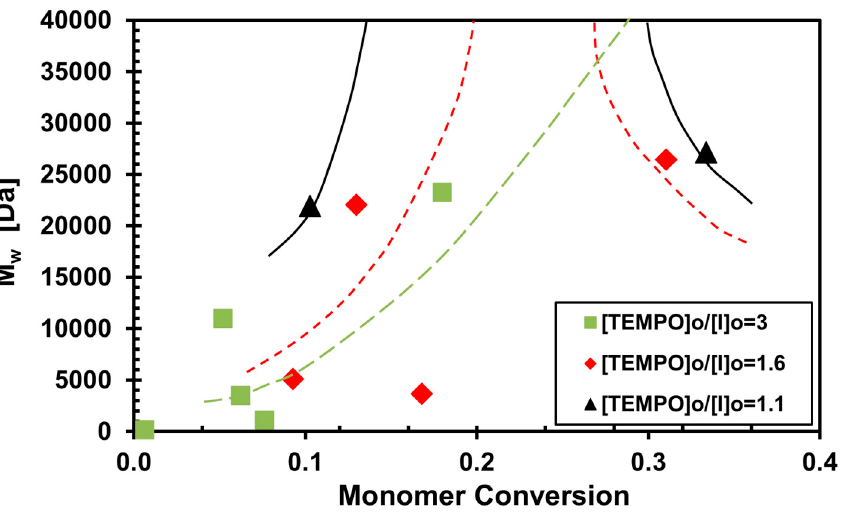
Figure 10. Effect of controller (TEMPO) content on the evolution of M w versus conversion for the NMC of STY/DVB in scCO 2 at [DVB] = 1 wt.%, T = 120 ◦ C, and P = 207